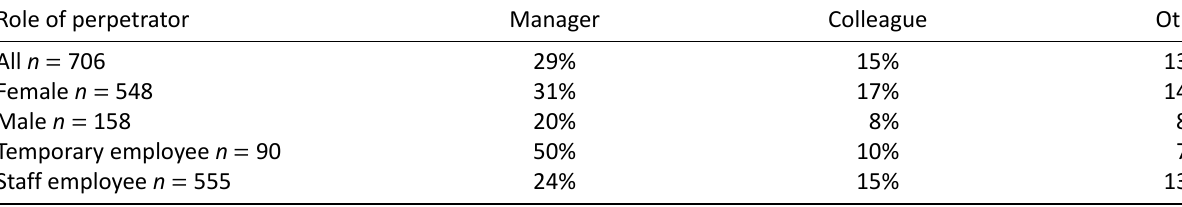
Table 7. Avoiding coping strategy and harassed by